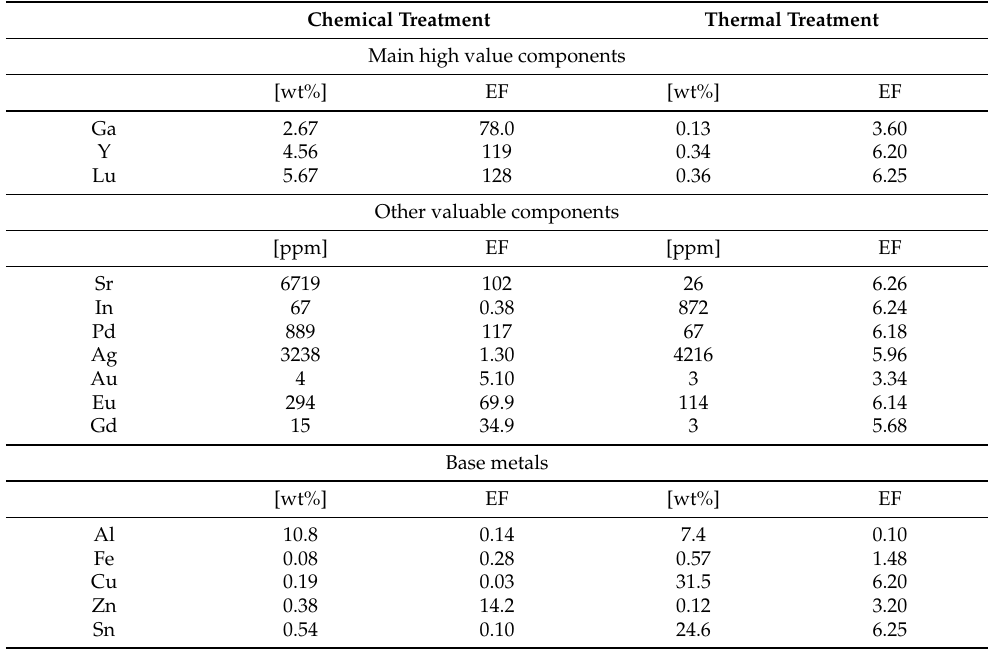
Table 3. Elemental composition of concentrates obtained after chemical and thermal treatment, and enrichment factor (EF) as percentage of the mass of the LED